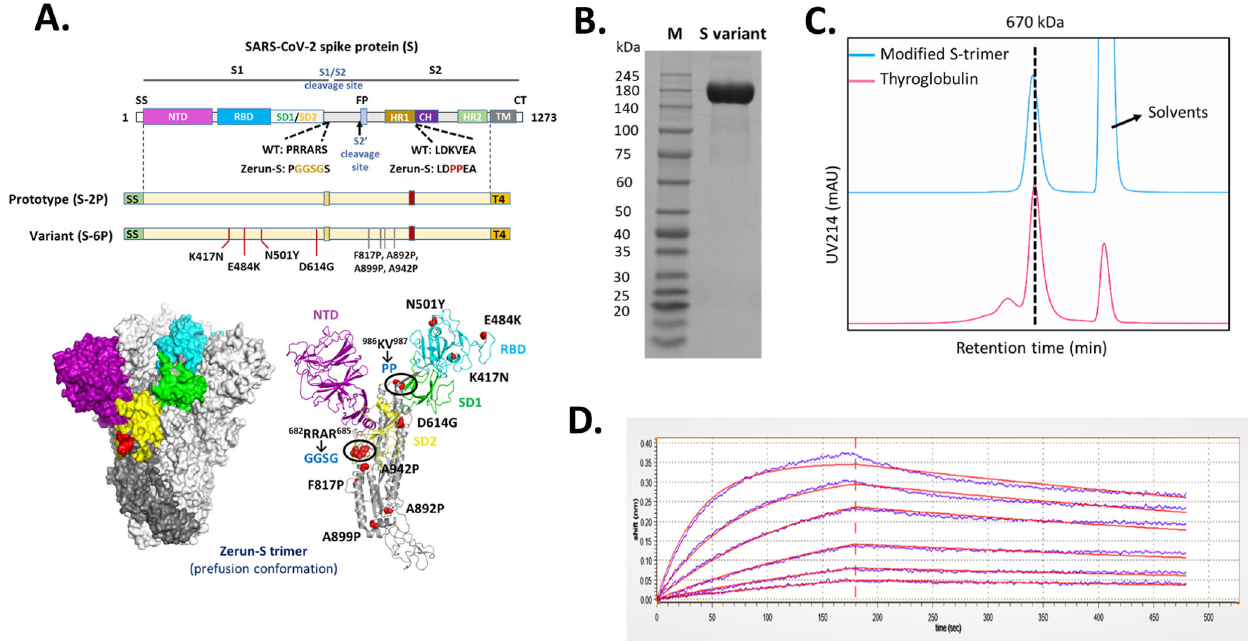
Fig. 1 Molecular design and characterization of variant S-trimer. A Domain architecture of the SARS-CoV-2 S protein. SS signal sequence, NTD N-terminal domain, RBD receptor-binding domain, SD1 subdomain 1, SD2 subdomain 2, S1/S2 S1/S2 protease cleavage site, S2' S2' protease cleavage site, FP fusion peptide, HR1 heptad repeat 1, CH central helix, CD connector domain, HR2 heptad repeat 2, TM transmembrane domain, CT cytoplasmic tail. Prototype S-trimer (S-2P) contains two consecutive proline substitutions at residues 986 and 987, a “ GGSG ” substitution at the furin cleavage site, and a C-terminal T4 fi britin trimerization motif. Variant S-trimer (S-6P) contains additional four bene fi cial proline substitutions (F817P, A892P, A899P, and A942P), and four hot spot residues (K417N, E484K, N501Y, and D614G). The structure model of S-trimer was generated by the SWISS-MODEL using homology modelling techniques (http://swissmodel.expasy.org/), and the 3D structure fi gures were prepared using PyMOL (www.pymol.org). B SDS-PAGE analysis of puri fi ed variant S-trimer. Molecular weight standards are indicated at the left in kDa. C Size-Exclusion HPLC chromatogram of puri fi ed variant S-trimer (shown as cyan line) and a 670 kDa molecular weight standard (shown as purple line). D Binding pro fi les of variant S-trimer to human ACE2 measured by BLI in GatorPrime. The data are shown as blue lines, and the best fi t of the data to a 1:1 binding model is shown in red. npj Vaccines (2022)